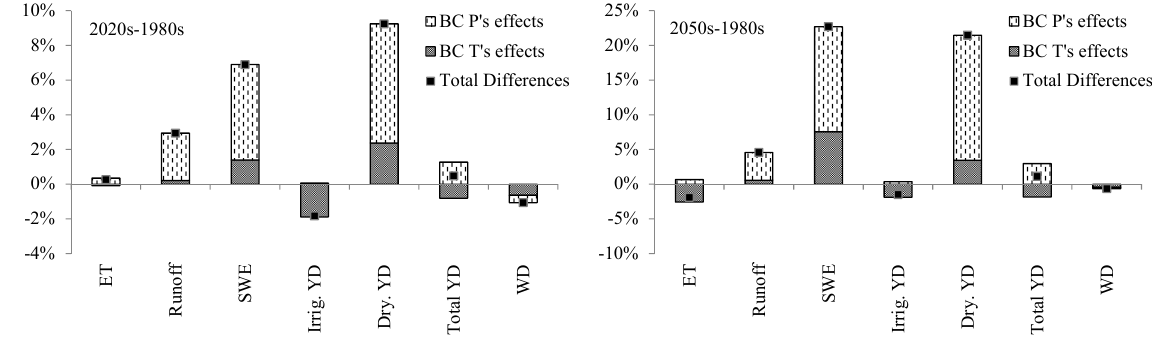
Fig. 7. Contributions of bias corrections (BC) on temperature ( T ) (Eq. 5) and precipitation ( P ) (Eq. 7) to the total differences (Eq. 3) of modeled changes in major hydrologic variables and crop yield between BC and NBC climate driving forces. Left panel: changes between the 1980s and 2020s; right panel: changes between the 1980s and 2050s. ET: average annual evapotranspiration; Runoff: total runoff; SWE: snowpack water equivalent on 1 April; Total YD: total yield from all croplands; Irrig. YD: yield from irrigated cropland; Dry. YD: yield from dryland (non-irrigated cropland); WD: total irrigation water demand over irrigated